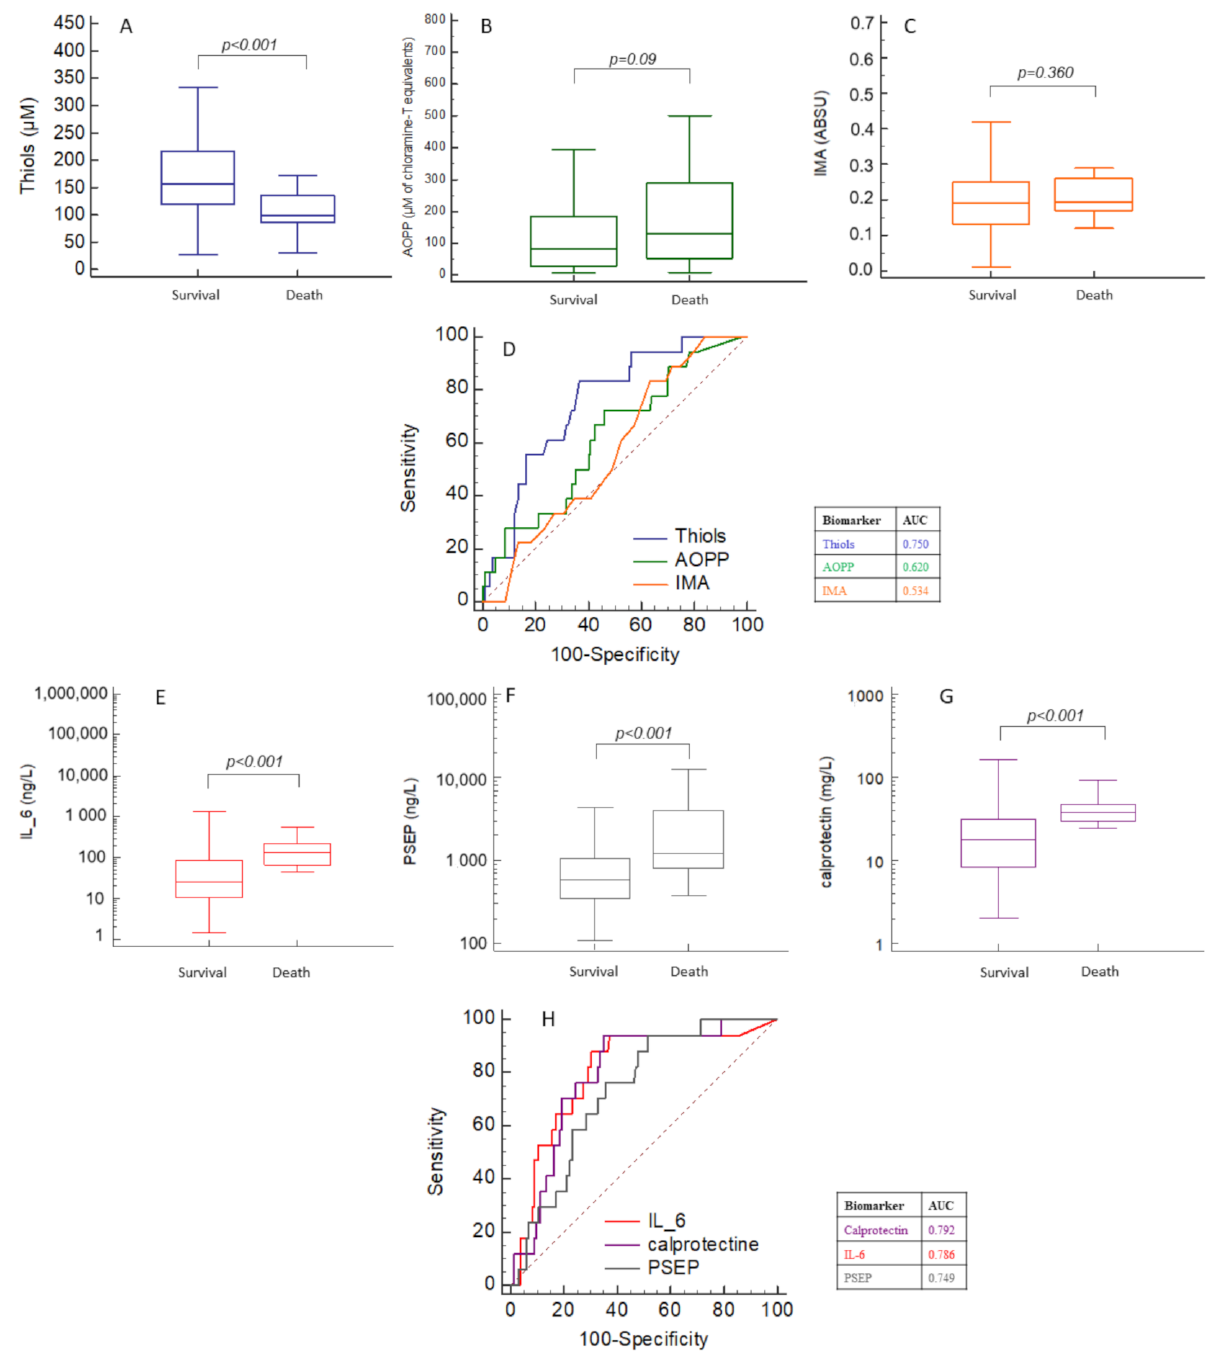
Figure 3. Box-plots and receiver operating characteristics (ROC) curve analysis of oxidative stress (OS), inflammation and cell-activation biomarker concentrations for the prediction of death. ( A – C ), thiols, AOPP and IMA concentrations according to death; ( D ), thiols, AOPP and IMA ROC curves and AUC values; ( E – G ), IL-6, presepsin, calprotectin concentrations according to death; ( H ) IL-6, presepsin, calprotectin ROC curves and AUC